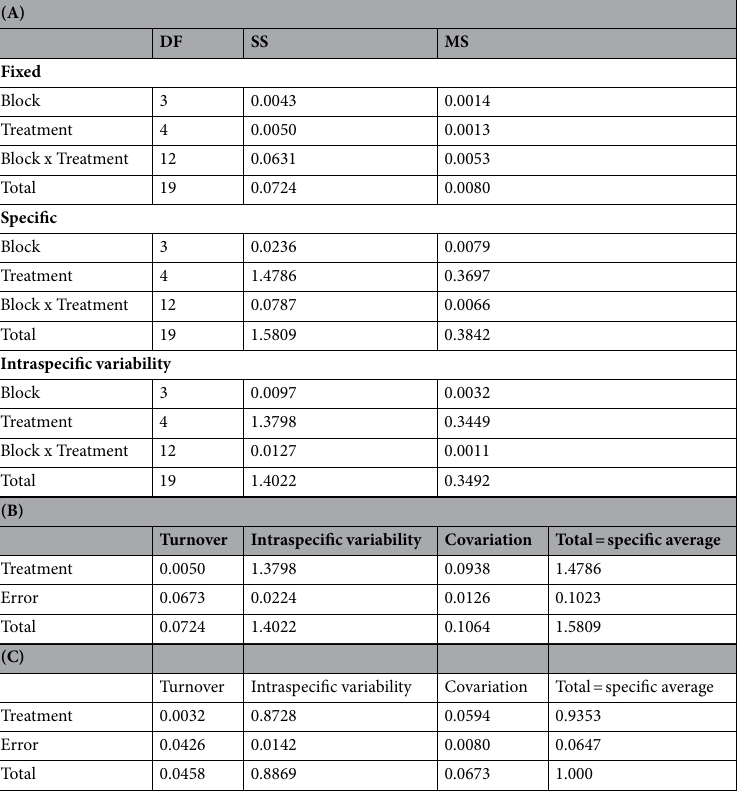
Table 4. Summary tables of the decomposition of total variability in leaf area. (A) Fixed averages, specific averages and intraspecific variability effect analyzed separately. (B) Variability of individual component of height variation, and their parts explained by experimental treatments. Covariation is obtained by subtracting the first two columns from the last. (C) Proportions of variability of individual components, and their parts explained by experimental treatments. SS (sum of squares) correspond to the amount of variability. Significant p -values ( p < 0.05) are in